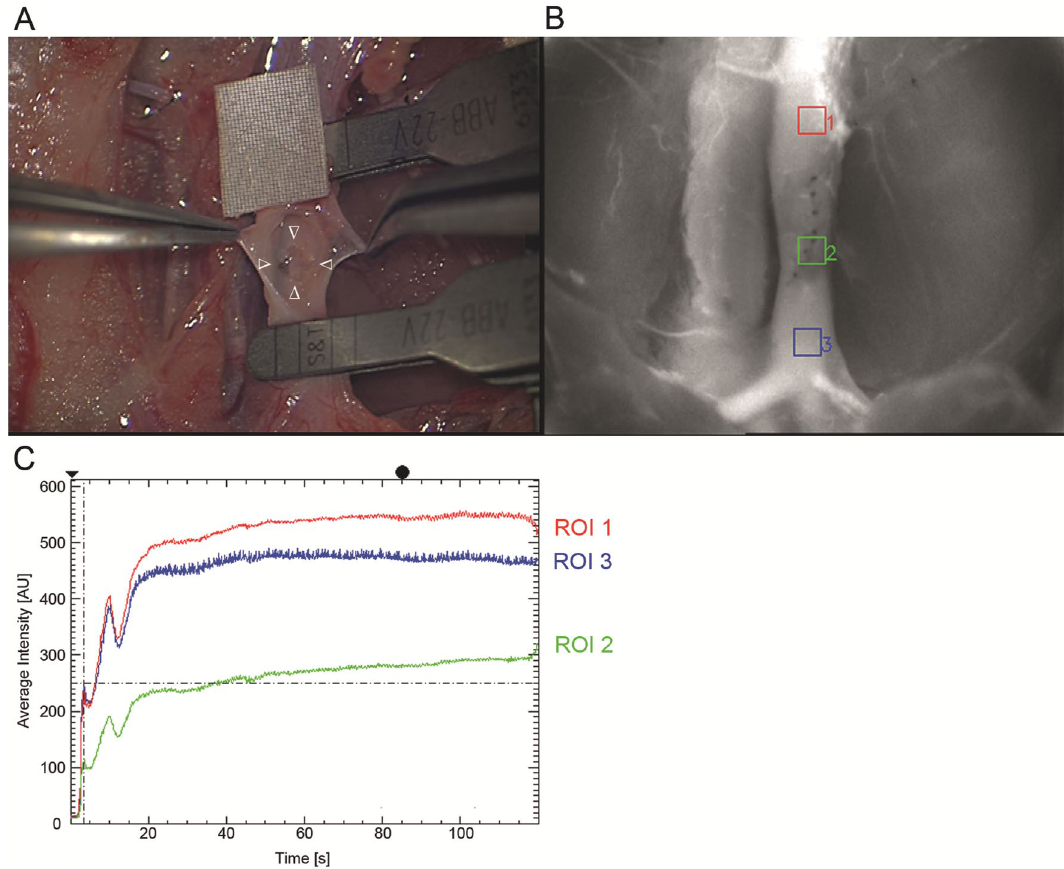
Figure 2. Endothelial defect (group I). ( A ) Prepared defect area (∆ indicating the borders of the defect), ( B ) three regions of interest (ROI, 1 = proximal, 2 = in, and 3 = distal to the ED), and ( C )corresponding fluorescence intensity curve (in AU) for capturing time of 120